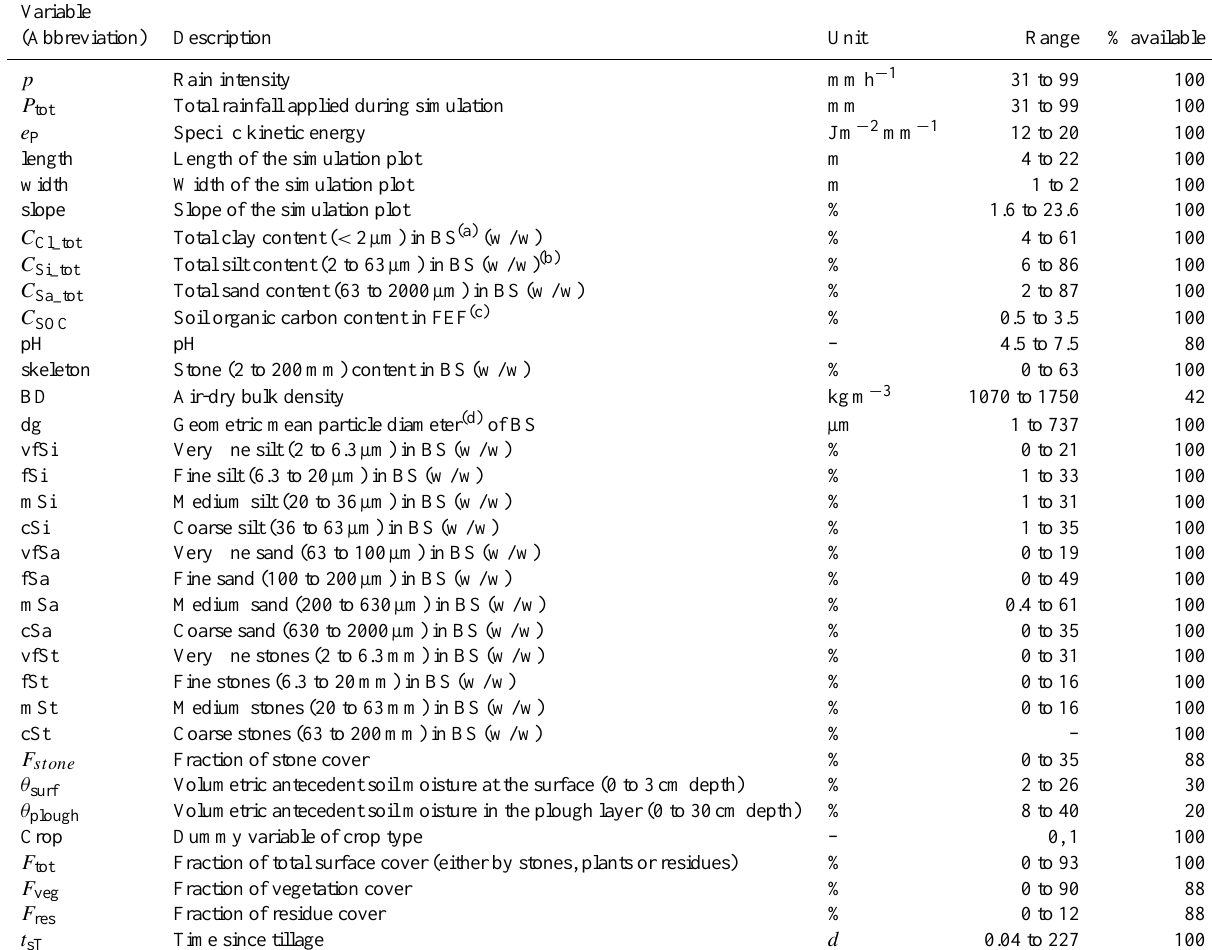
Table 1. List of rain, plot, soil and land use variables used to explain runoff hydrographs; all soil properties were determined for the plough horizon (approximate depth 0.3m), if not otherwise indicated. The availability of each variable relative to the total number of runs ( n = 317) in percent (% available) is also